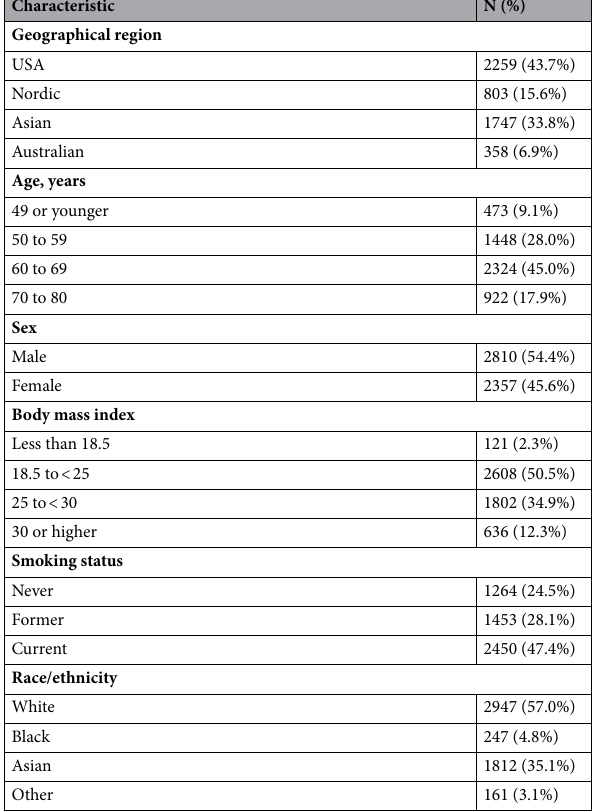
Table 1. Descriptive characteristics of 5167 control subjects in the Lung Cancer Cohort Consortium. The study population includes cancer-free control subjects from the Lung Cancer Cohort Consortium, which comprises 20 cohorts from the USA (Campaign Against Cancer and Stroke and Campaign Against Cancer and Heart Disease (CLUE, N = 171), American Cancer Society Cancer Prevention Study-II Nutrition Cohort (CPS-II, N = 179), Health Professionals Follow-Up Study (HPFS, N = 130), Multiethnic Cohort (MEC, N = 148), Nurses’ Health Study (NHS, N = 328), New York University Women’s Health Study (NYUWHS, N = 167), Physicians’ Health Study (PHS, N = 76), Prostate Lung Colorectal and Ovarian Cancer Screening Trial (PLCO, N = 440), Southern Community Cohort Study (SCCS, N = 209), Women’s Health Initiative (WHI, N = 228), Women’s Health Study (WHS, N = 183)), Nordic countries (Alpha-Tocopherol, Beta-Carotene Cancer Prevention Study (ATBC, N = 200), Trøndelag Health Study (HUNT, N = 174), Northern Sweden Health and Disease Study Cohort (NSHDS, N = 230), Malmö Diet and Cancer Study (MDCS, N = 199)), Asia (Shanghai Men’s Health Study (SMHS, N = 419), Shanghai Women’s Health Study (SWHS,N = 417), Shanghai Cohort Study (SCS, N = 502), Singapore Chinese Health Study (SCHS, N = 409)), and Australia (Melbourne Collaborative Cohort Study (MCCS, N = 358)). Details regarding the data from individual cohorts have been published previously 7